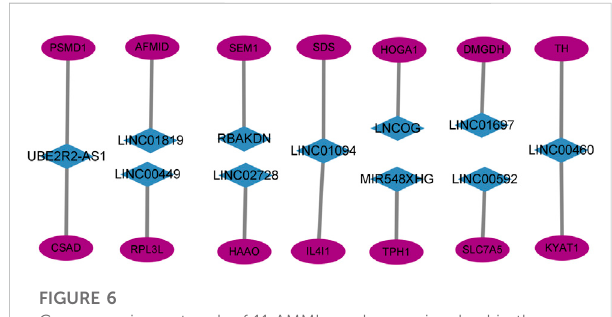
FIGURE 6 Co-expression network of 11 AMMLs and genes involved in the metabolism of amino acids. AMMLs, Amino acid metabolism-related LncRNAs.